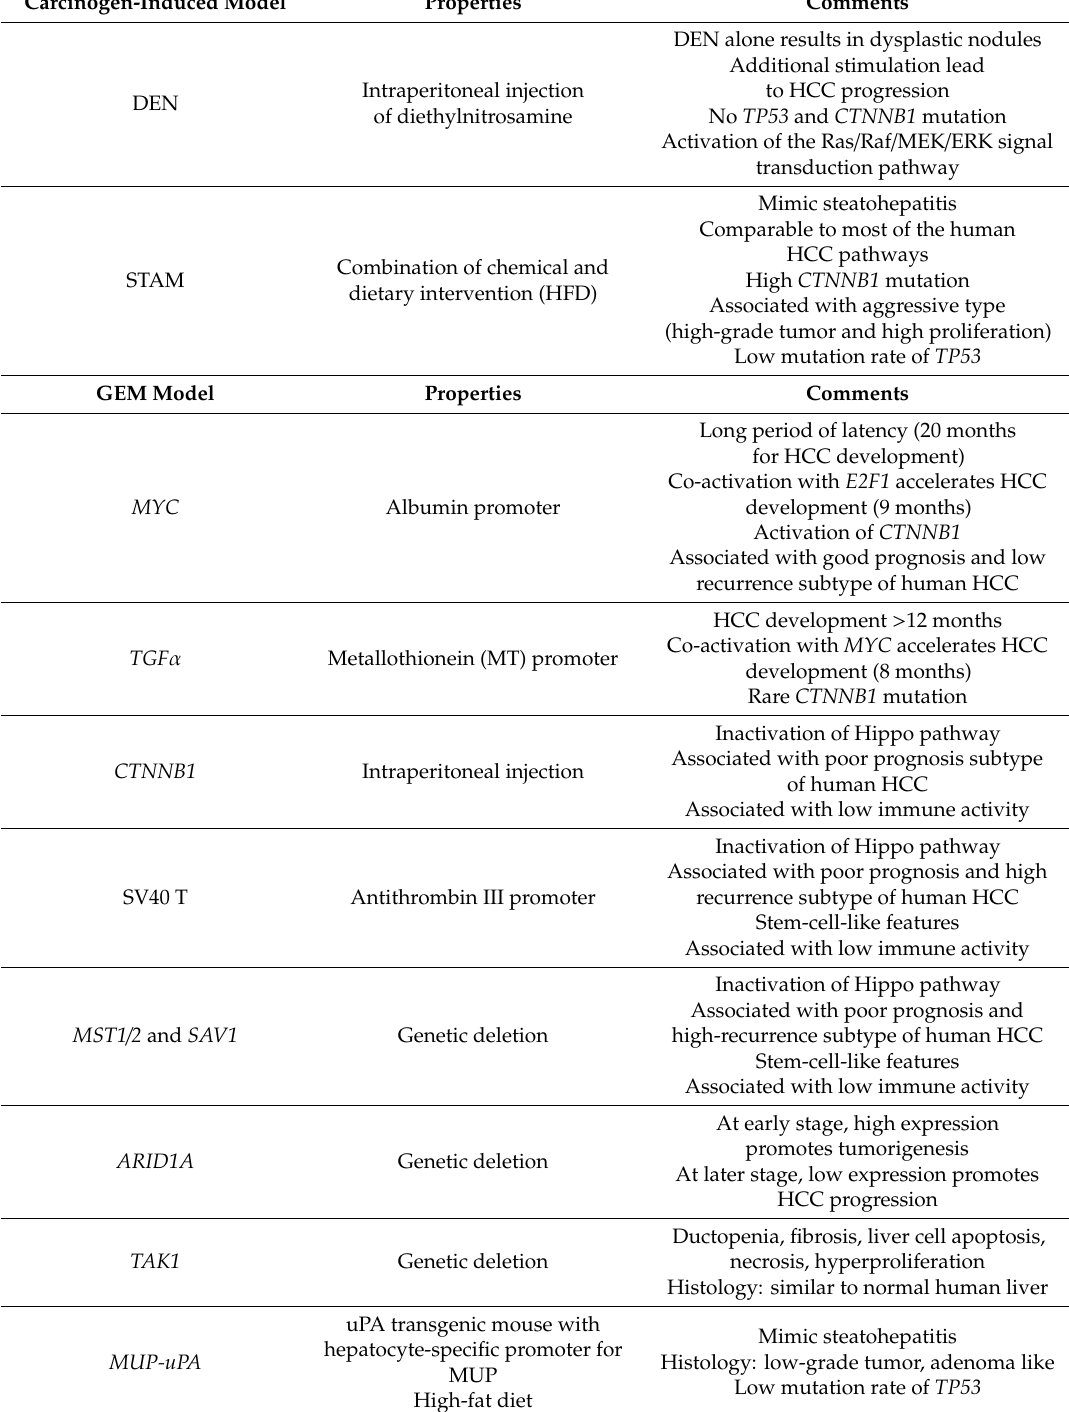
Table 1. Summary of mouse hepatocellular carcinoma (HCC) models with genomic resemblance to human